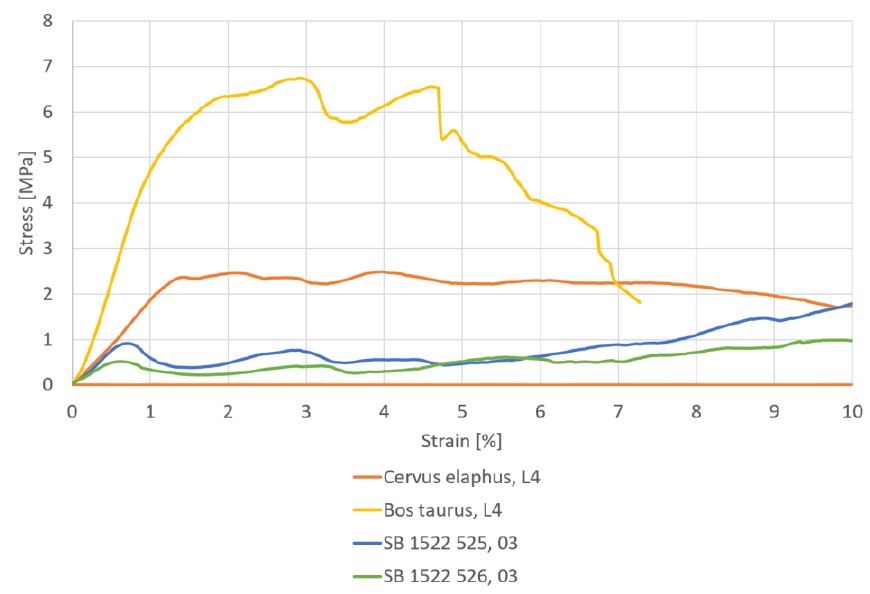
Figure 4. Stress – strain curves for the four samples determined in the uniaxial compression test. Figure 4. Stress–strain curves for the four samples determined in the uniaxial compression